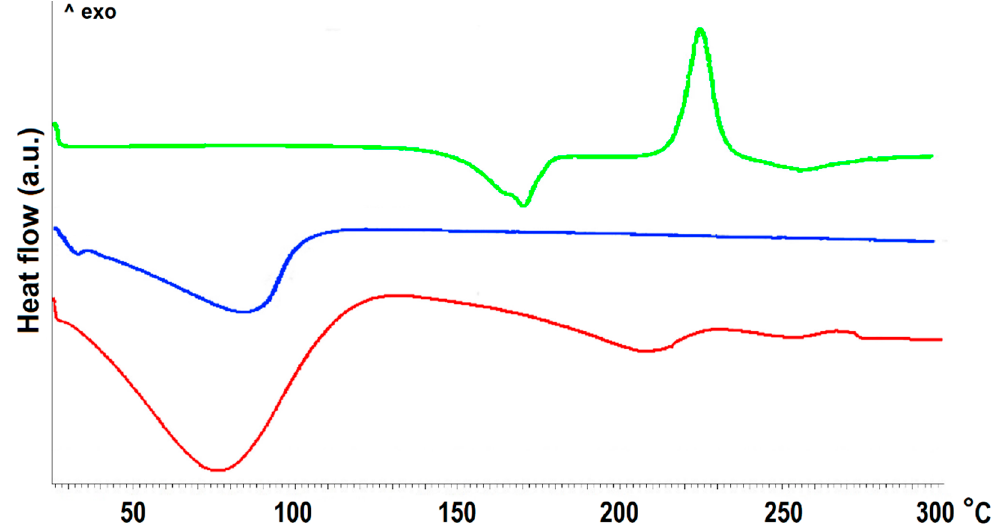
Figure 1. The DSC curves of MCM-41 before (blue) and after (red) DOX adsorption together with DOX reference sample (green).